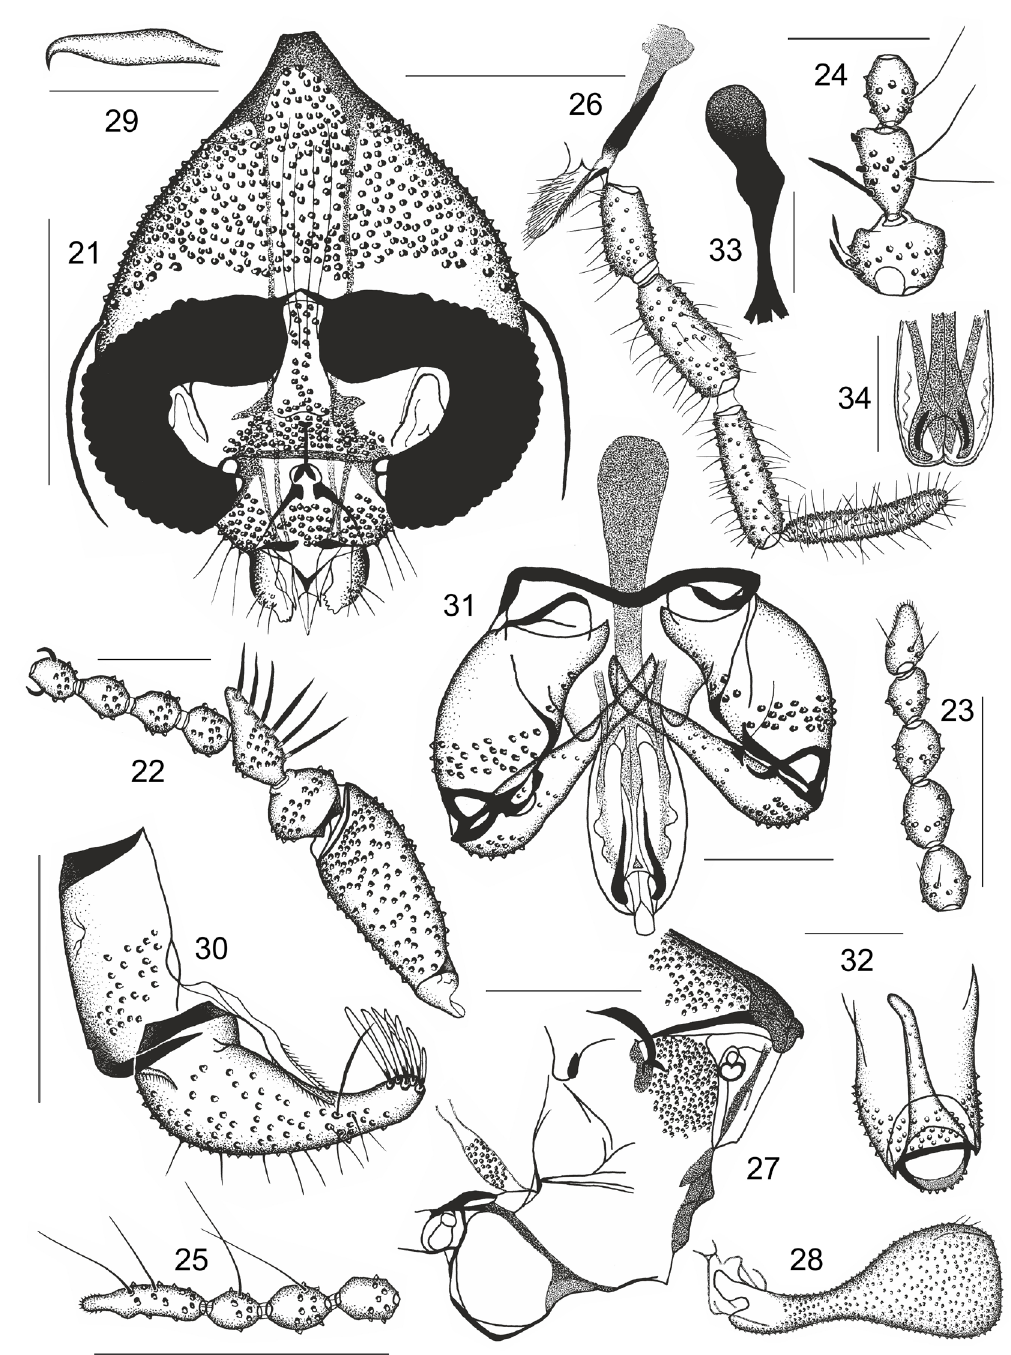
Figs 21–34. Thornburghiella salihi sp. nov., ♂. 21 . Head, frontal view. 22 . Scape, pedicel and basal flagellomeres, ascoids. 23 . Apical flagellomeres. 24 . Pedicel, basal two flagellomeres (variability). 25 . Fusion of apical flagellomeres (variability). 26 . Maxilla and palpus maxillaris. 27 . Thoracic sclerites, lateral view. 28 . Halter, lateral view. 29 . Tarsal claw of P , lateral view. 30 . Epandrial appendages, 1 lateral view. 31 . Aedeagal complex, gonopods and hypandrium, dorsal view. 32 . Gonopod, lateral view. 33 . Basiphallus, dorsal view (variability). 34 . Distiphallus, dorsal view (variability). Scale bars: 21, 27–28 = 0.3 mm; 22–24, 31–34 = 0.1 mm; 25–26, 30 = 0.2 mm; 29 = 0.03